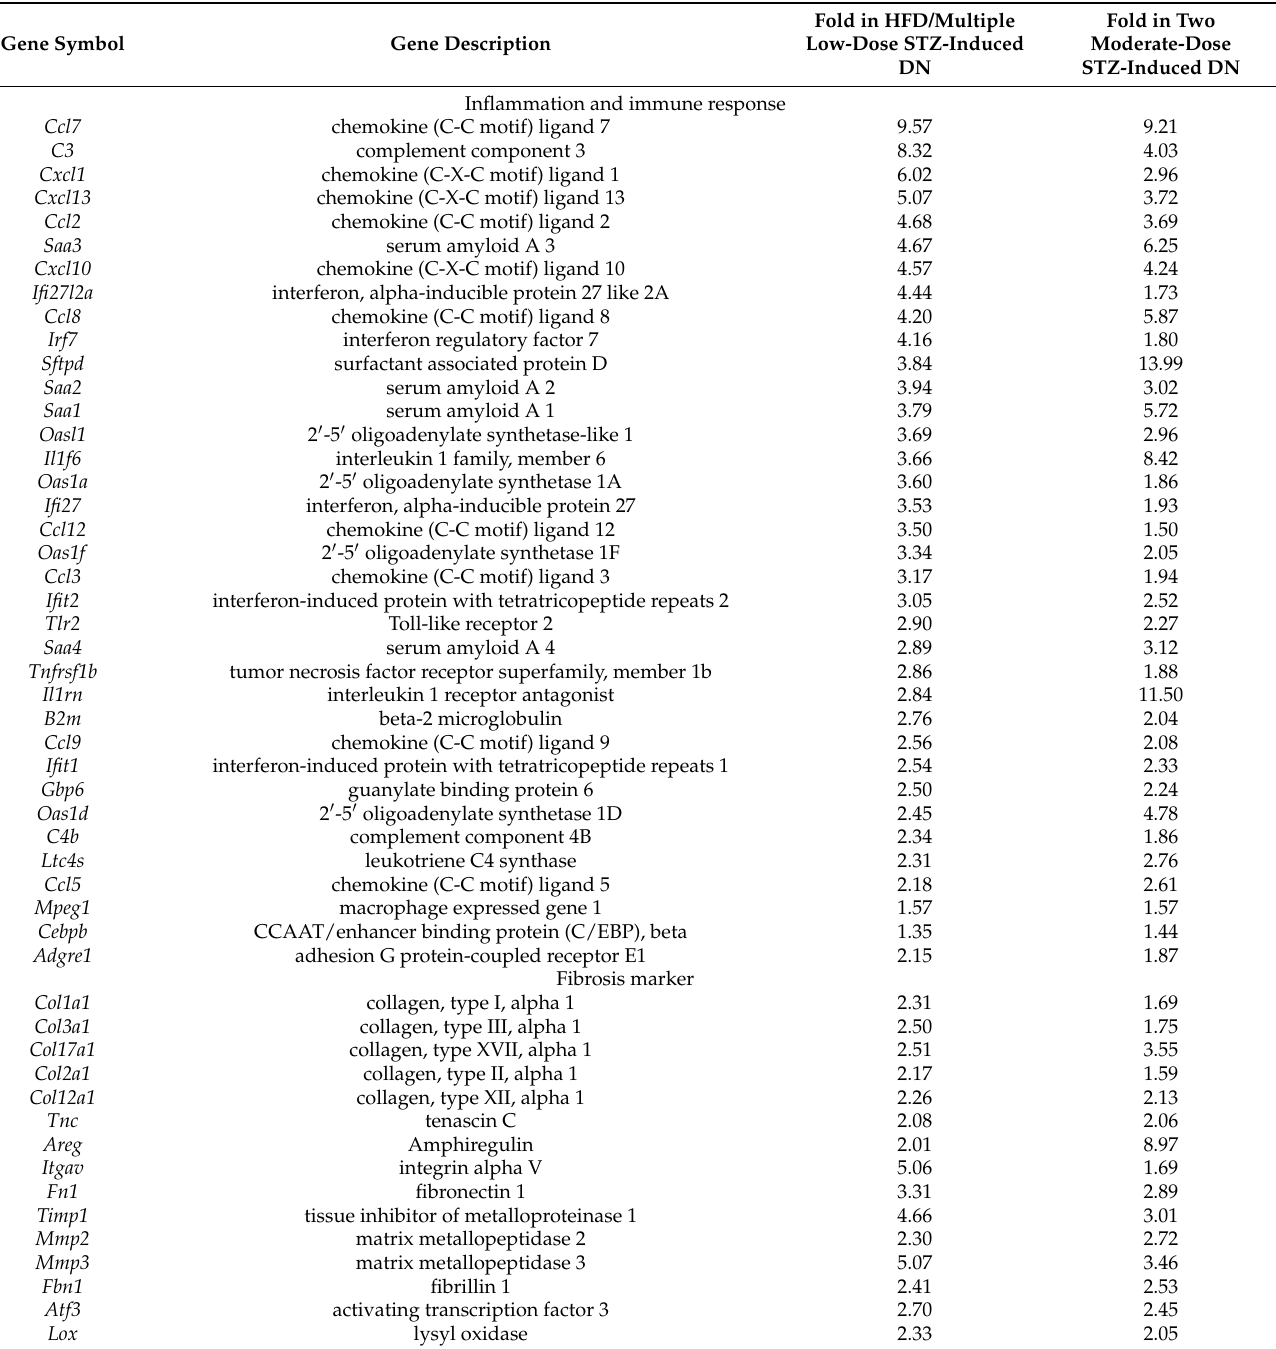
Table 1. Representative upregulated genes in both models ( p ≤